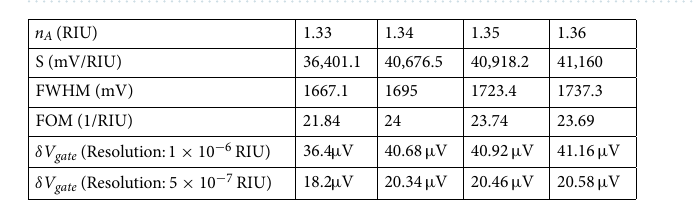
Table 1. Sensitivity (S), full width at half maximum (FWHM), and figure of merit (FOM) of the biosensor evaluated for the four samples.